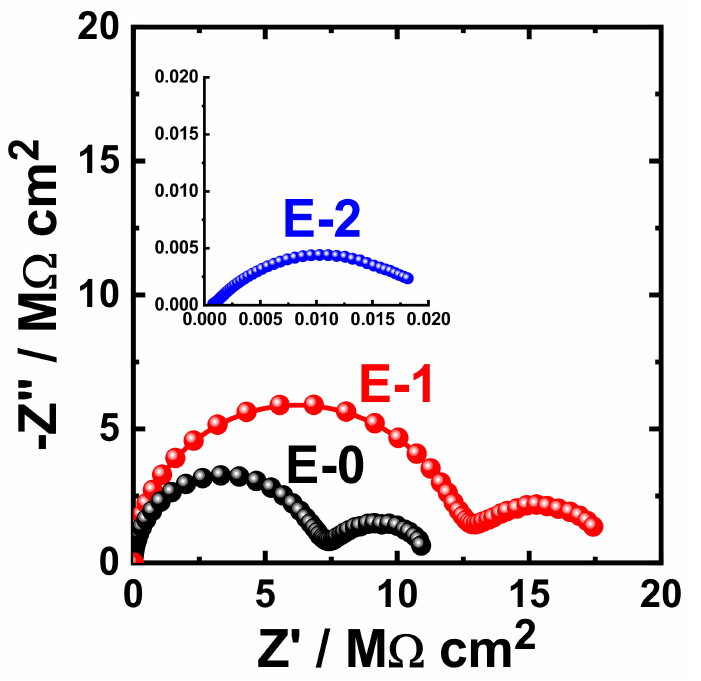
Figure 13. Typical Nyquist plots obtained for E-0, E-1, and E-2 after their immersion in 3.5% NaCl solutions for 30